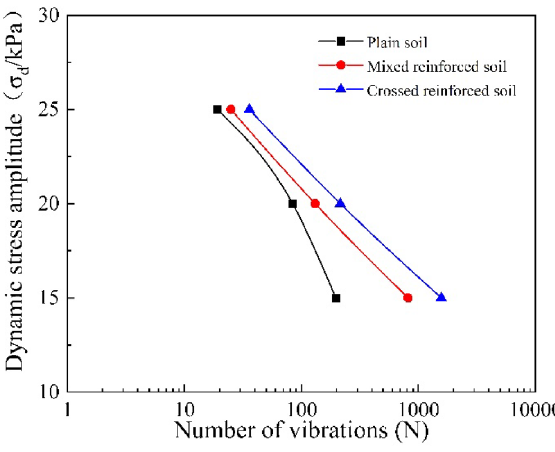
Figure 5. Dynamic strength curve-dynamic stress amplitude vs number of